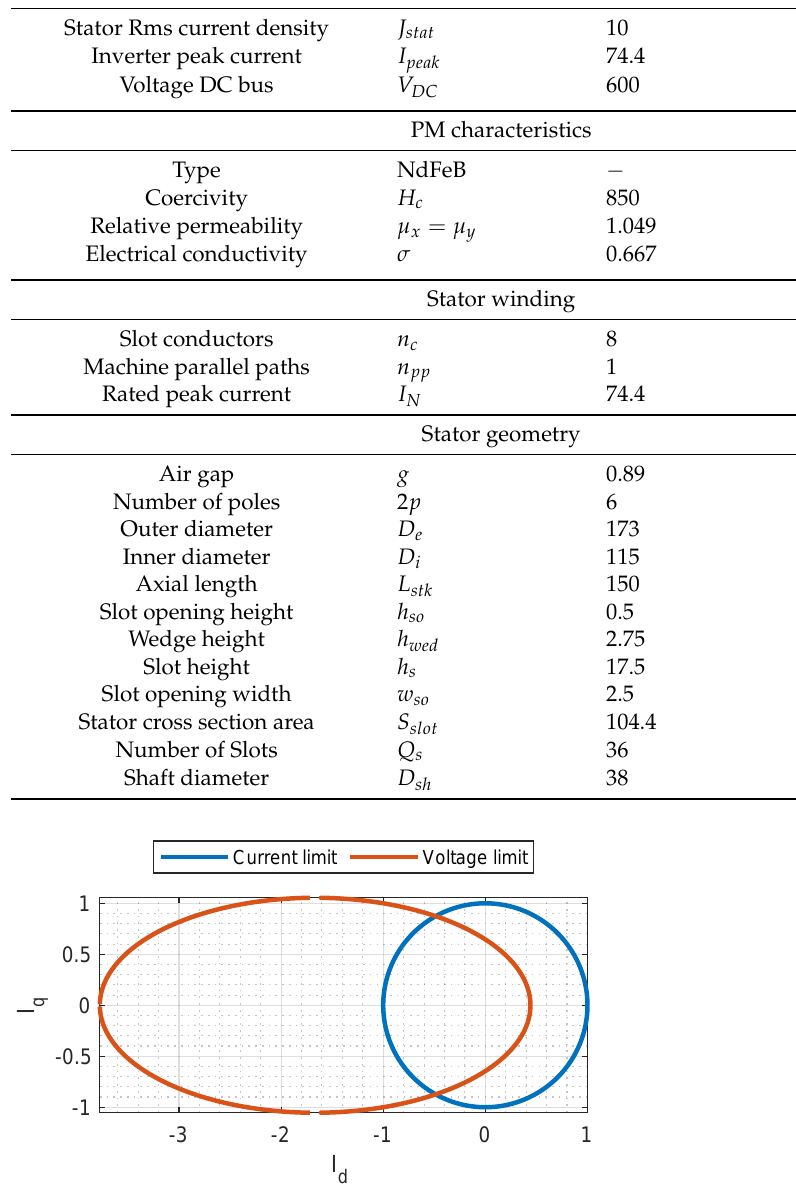
Figure 1. Voltage and current equations represented in I d / I q plane. Unlike traditional IPM motor equations, torque (1) and voltage (2) are expressed as a function